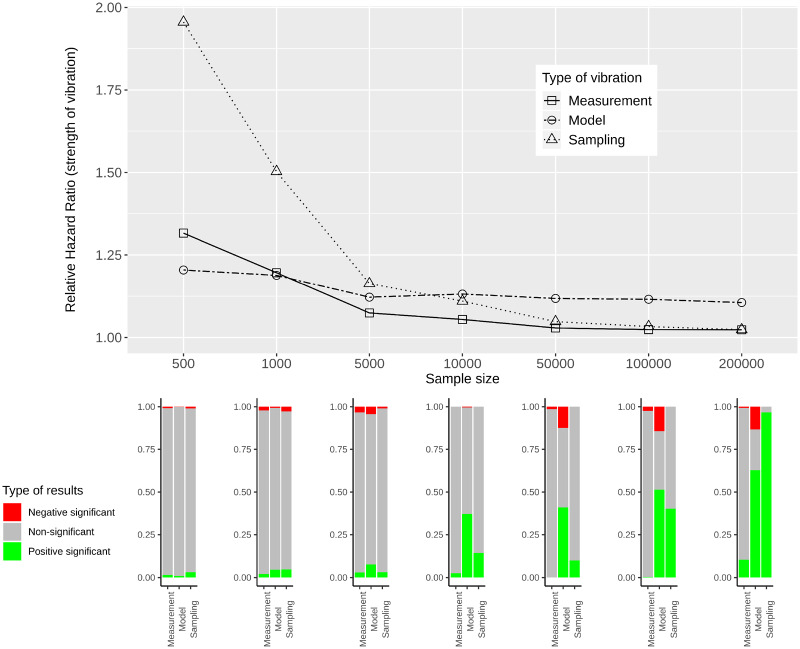
Measurement, model and sampling vibration for different sample sizes (top panel), and bar plots showing the type of results in terms of significance of estimated effects (bottom panel) for the association of HDL-cholesterol with mortality